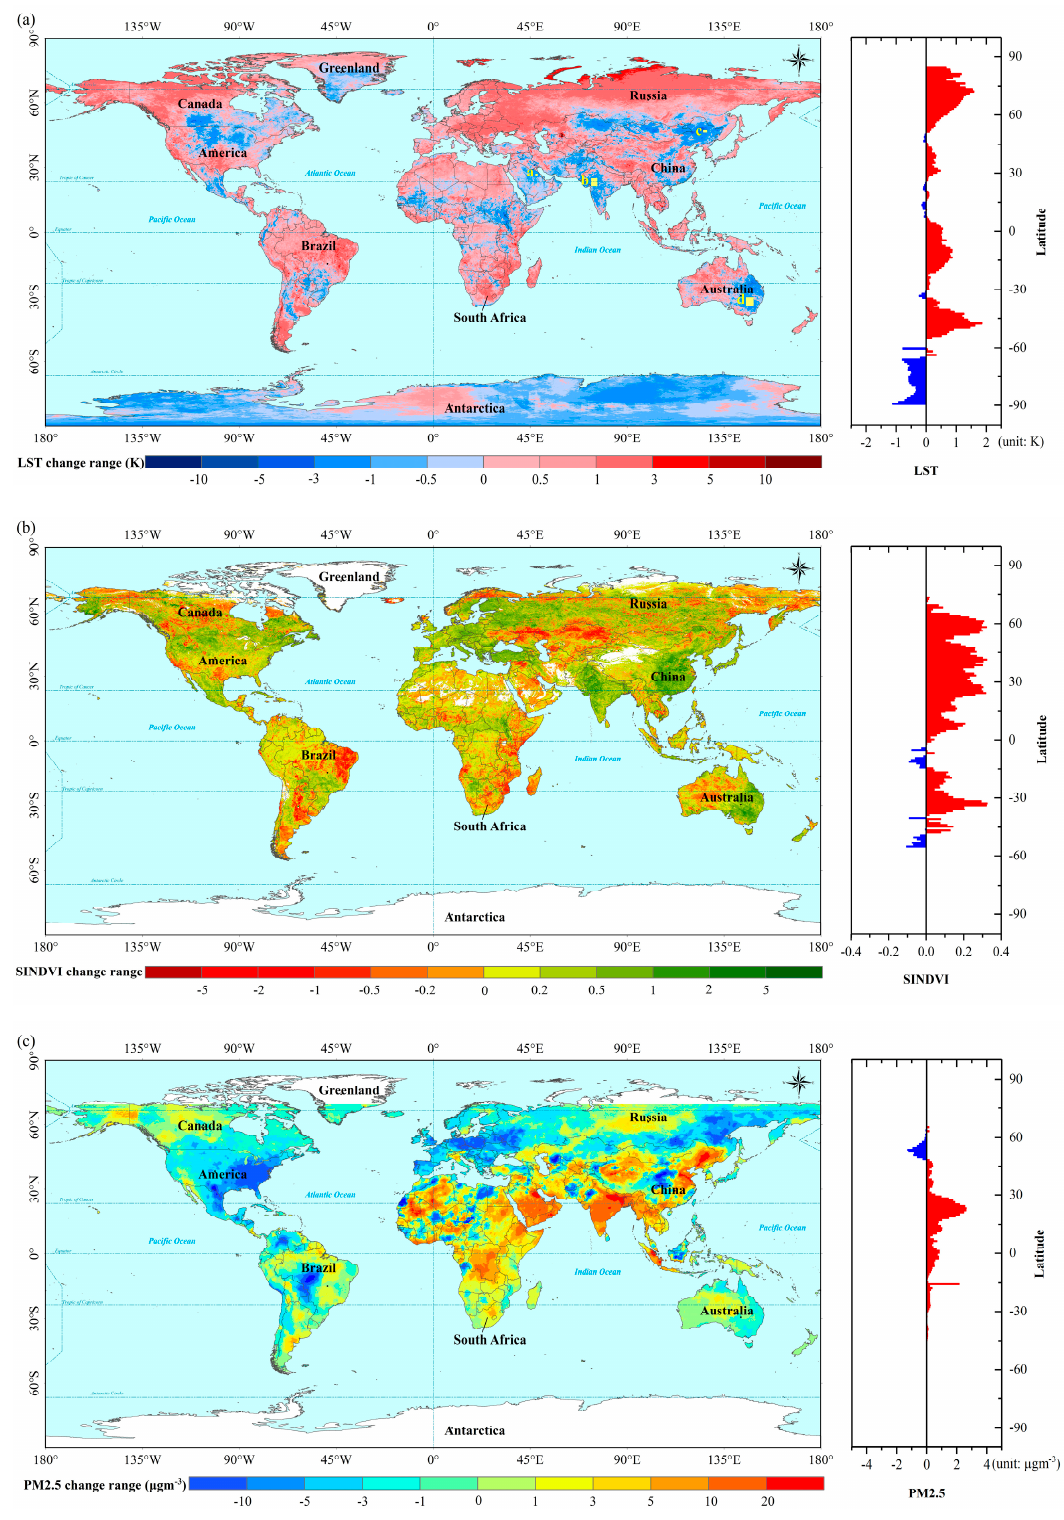
Figure 1. Changes (left) of LST ( a ), SINDVI ( b ) and PM 2.5 ( c ), and the latitudinal characteristics (right) of the variation trends in LST, SINDVI and PM 2.5 from 2001 to 2016. LST was measured in Kelvin, SINDVI was unitless, and PM 2.5 concentrations were measured in µ g/m 3 . The yellow regions in Figure 1a referred to regions of interest (ROIs) where LST decreased sharply. The locations of four ROIs were shown in Table